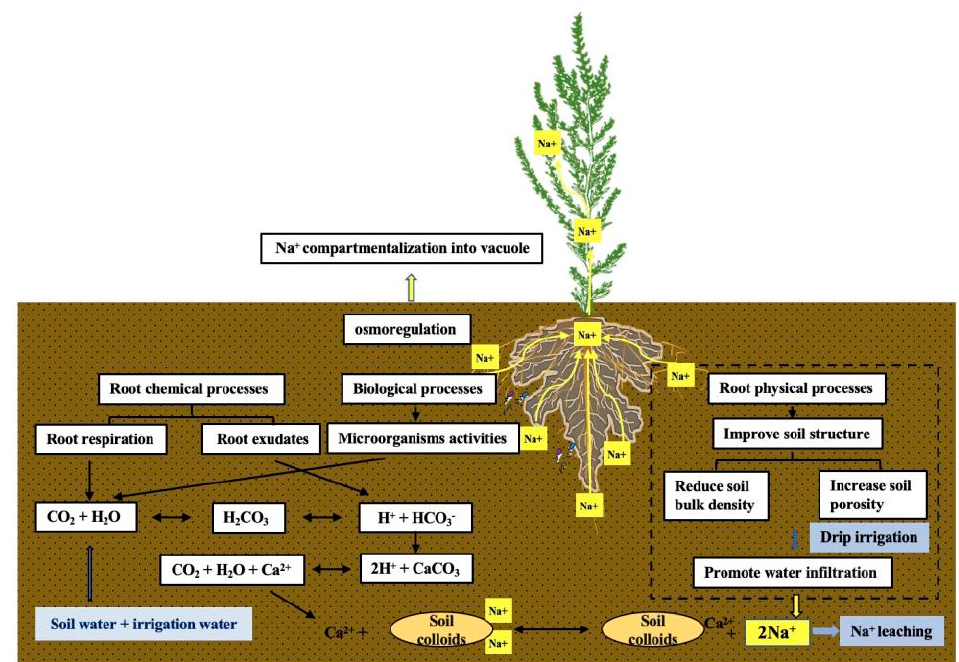
Figure 2. The different processes of euhalophyte remediation of salinized soil.